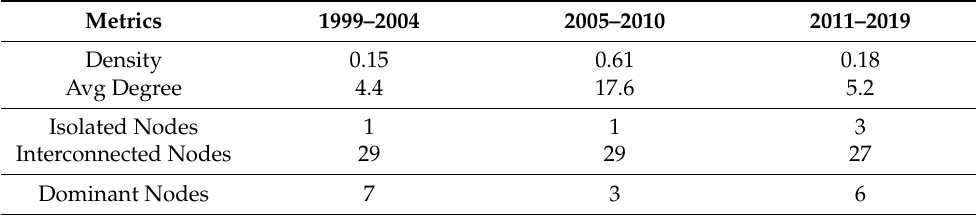
Table 9. Network metrics for 0.8 threshold level on the General Government Debt (% of GDP) variable.